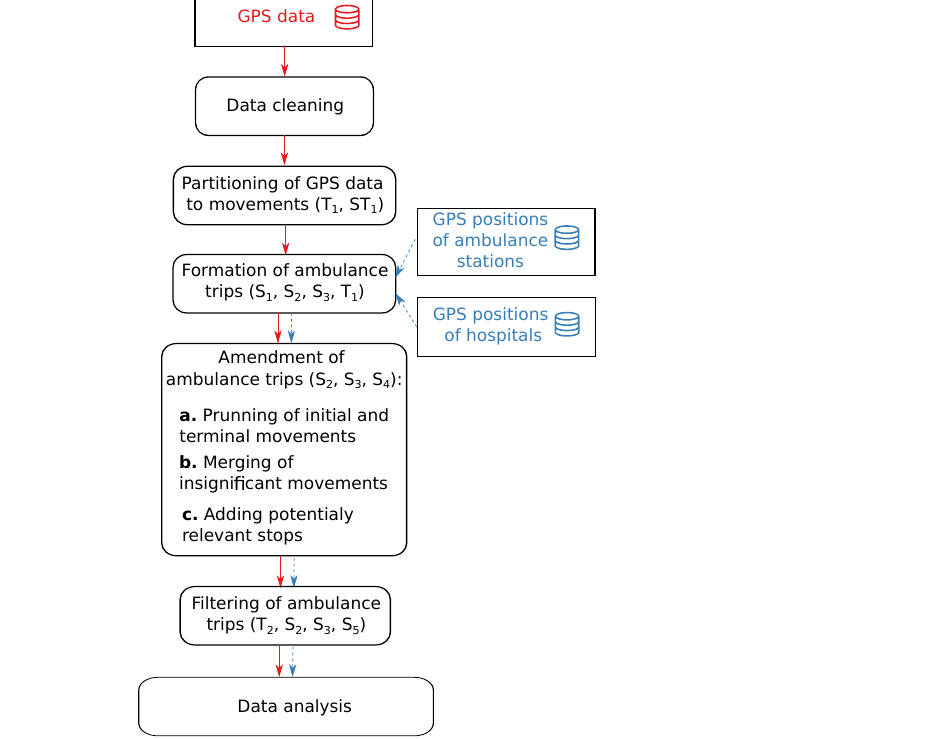
Figure 2. A schematic illustrating the workflow applied to GPS-based data. Symbols enclosed in brackets indicate spatial and temporal characteristics used the in rules applied by the workflow. For the explanation of symbols please see the